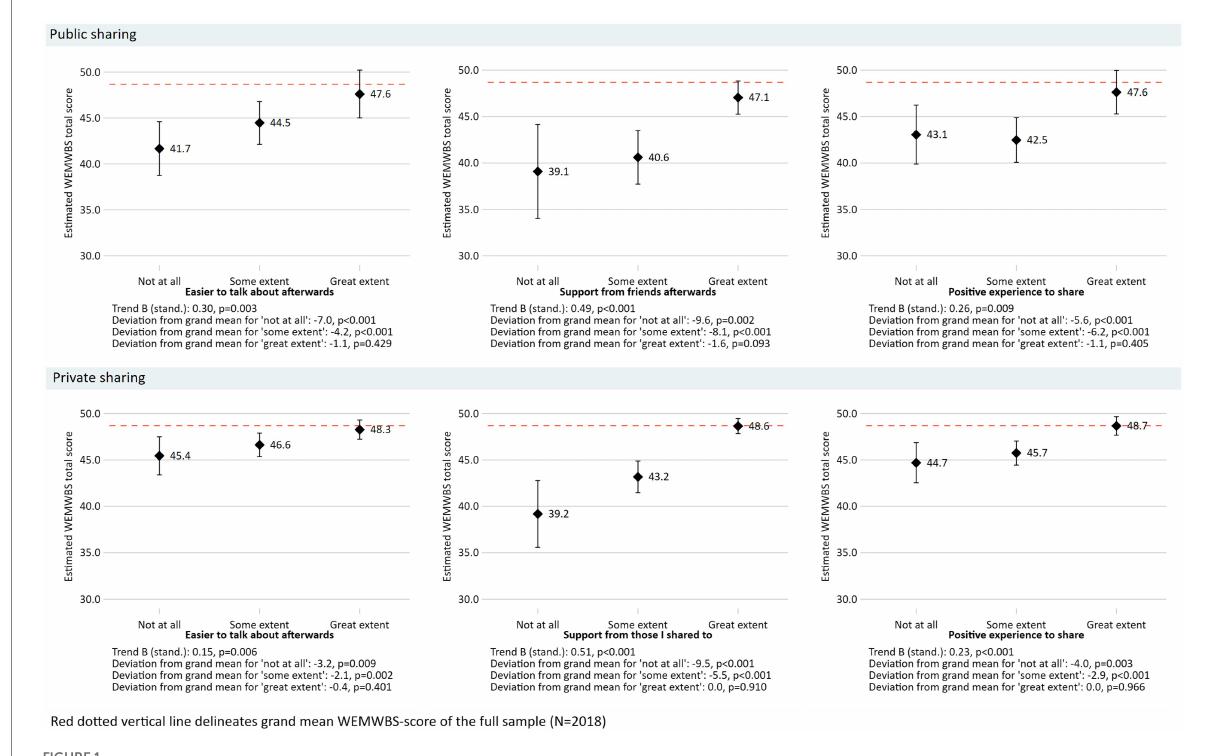
FIGURE 1 Results from bivariate linear regression analyses for public and private sharing and the related social support statements. WEMWBS is the dependent variable. Estimated total scores across response options. B (stand.) was computed using a Z-scored (mean 0; standard deviation 1) dependent